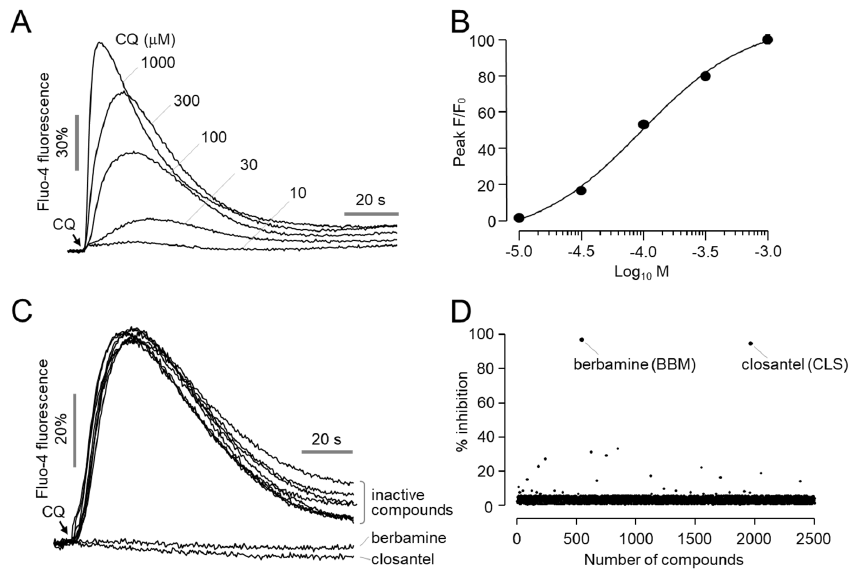
Figure 1. Identification of novel antagonists of MrgprX1: ( A ) Intracellular calcium levels were measured using Fluo − 4 NW in HEK293T cells expressing human MrgprX1. Cells were treated with the indicated concentrations of CQ where the arrow indicates. ( B ) Summary of dose-response (mean ± S.E., n = 6). ( C ) Representative Fluo − 4 fluorescence traces of MrgprX1 antagonist screening. Cells were treated with 30 μ M of the test compounds for 10 min prior to treatment with 300 μ M CQ. ( D ) Scatter plot showing the results of MrgprX1 antagonist screening for 2543 compounds.